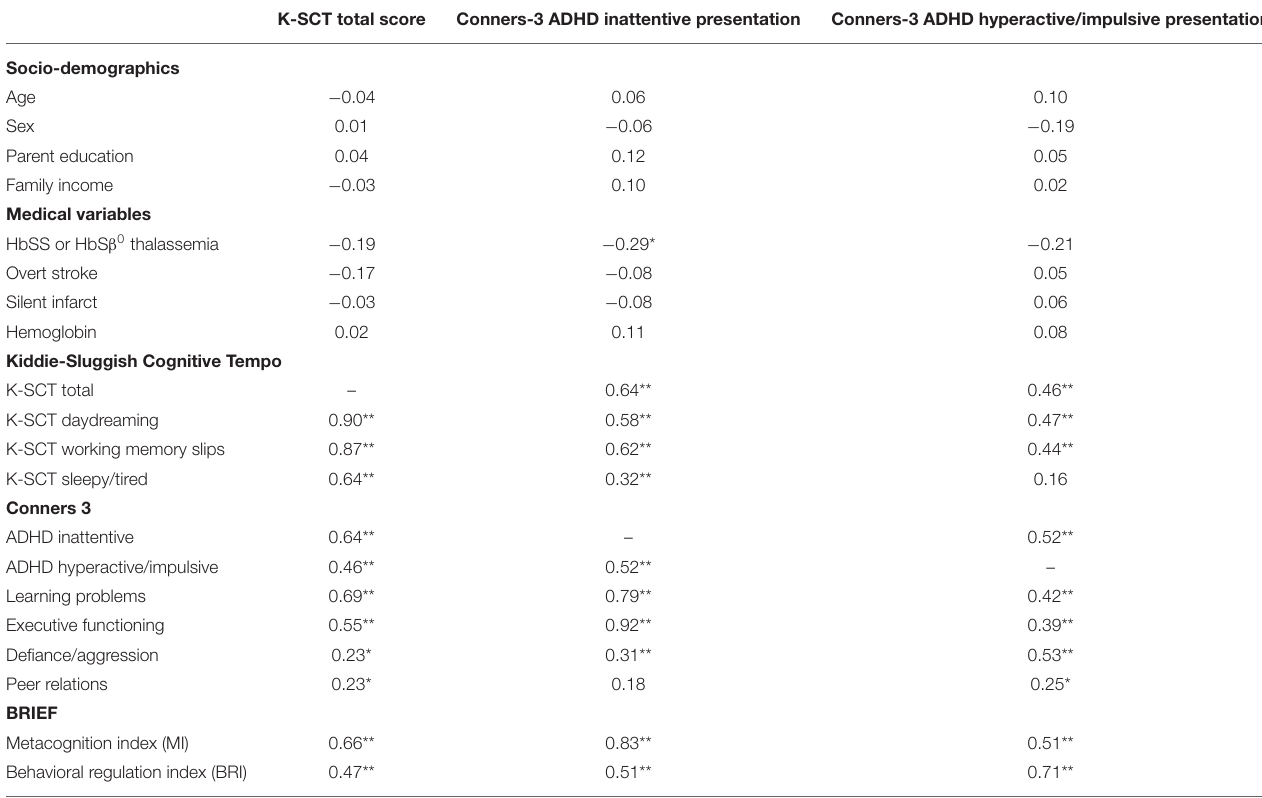
TABLE 2 | Correlations between Kiddie-Sluggish Cognitive Tempo scores, related constructs, and socio-demographic and disease characteristics. K-SCT total score Conners-3 ADHD inattentive presentation Conners-3 ADHD hyperactive/impulsive